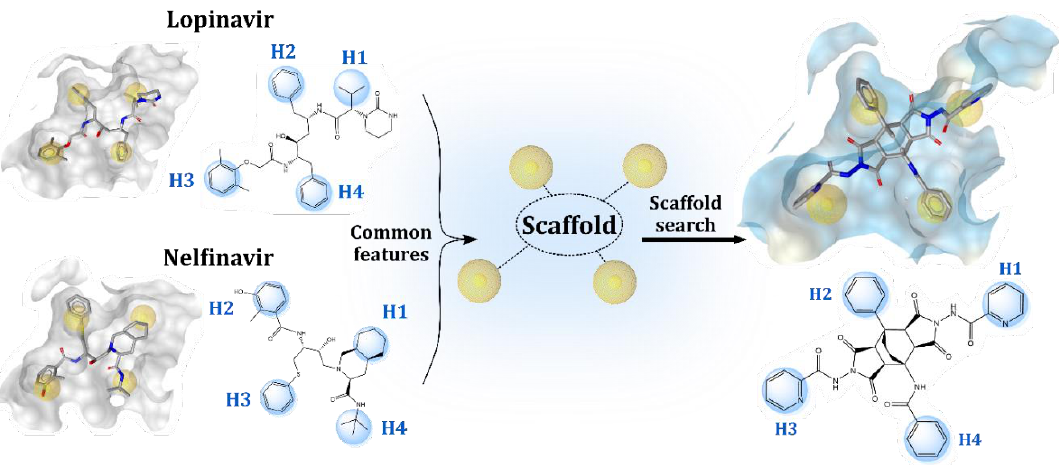
Figure 2. Structure-based design of fused bicyclo[2.2.2]octene as to SARS-CoV-2 3CL pro inhibitors. HIV-1 protease inhibitors nelfinavir and lopinavir contain four hydrophobic moieties that, according to docking study, can fit into sub-pockets of the 3CL pro active site. Model compound 11a with fused bicyclo[2.2.2]octene scaffold is able to mimic this pharmacophore pattern when docked in the 3CL pro active site.